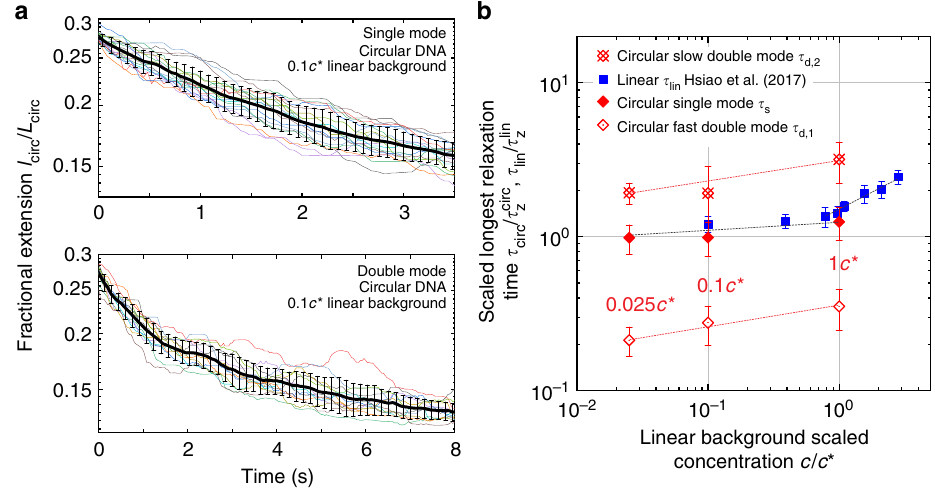
Fig. 2 Relaxation of single ring polymers in semidilute linear polymer solutions. a Single molecule relaxation trajectories and average relaxation for molecular subpopulations corresponding to (top) single-mode and (bottom) double-mode exponential relaxation trajectories for ring polymers in a background solution of 0.1 c * linear chains. Black curves with error bars (standard deviation) denote the ensemble averaged relaxation trajectory, and the solid thin curves (color) correspond to single molecule relaxation trajectories. Molecular ensembles consist of n = 18 molecules for single-mode relaxation and n = 13 molecules for double-mode relaxation at 0.1 c * . b Longest relaxation times (normalized to dilute solution values) for circular (red diamonds) and linear polymers (blue squares) in semidilute unentangled linear solutions as a function of scaled concentration c / c * . Source data are provided as a